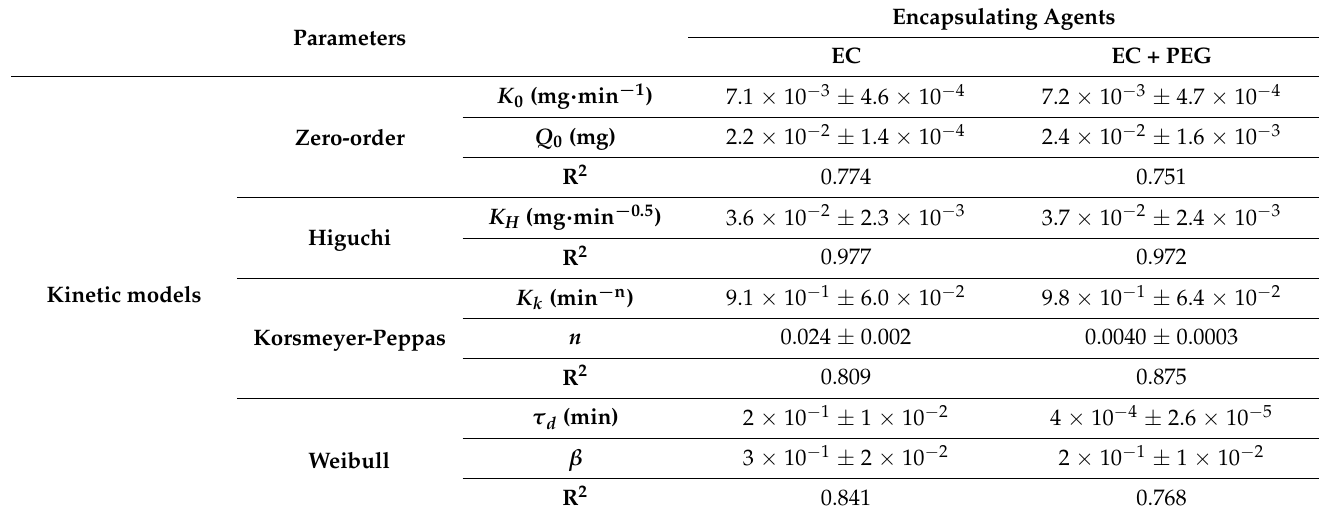
Table 2. Parameters and correlation coefficients of zero-order, Higuchi, Korsmeyer-Peppas, and Weibull models fitted to the experimental RA release